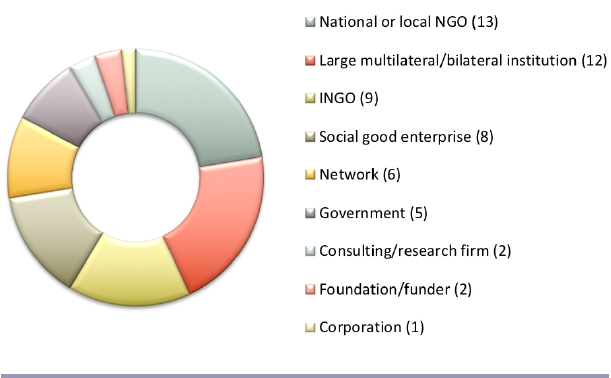
Fig. 3 . Type of organization in which the Fellow was affiliated at the time of beginning the